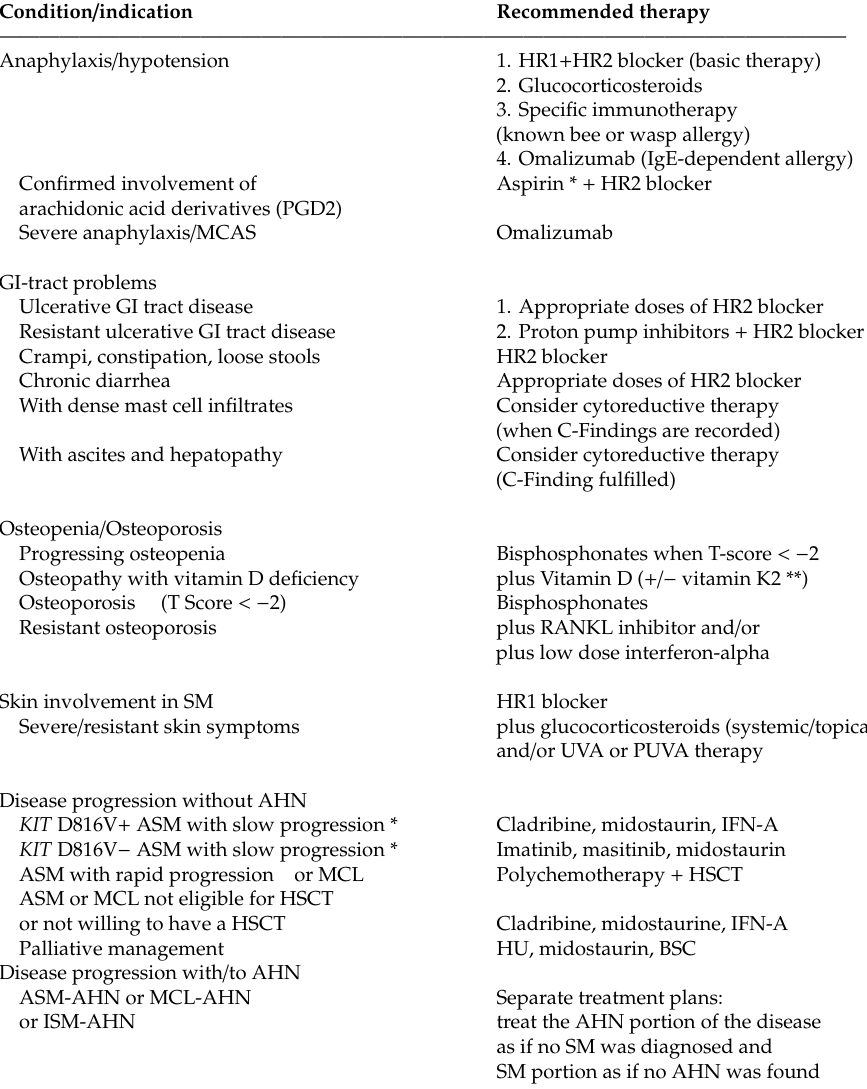
Table 5. Precision medicine-based therapy in patients with systemic mastocytosis